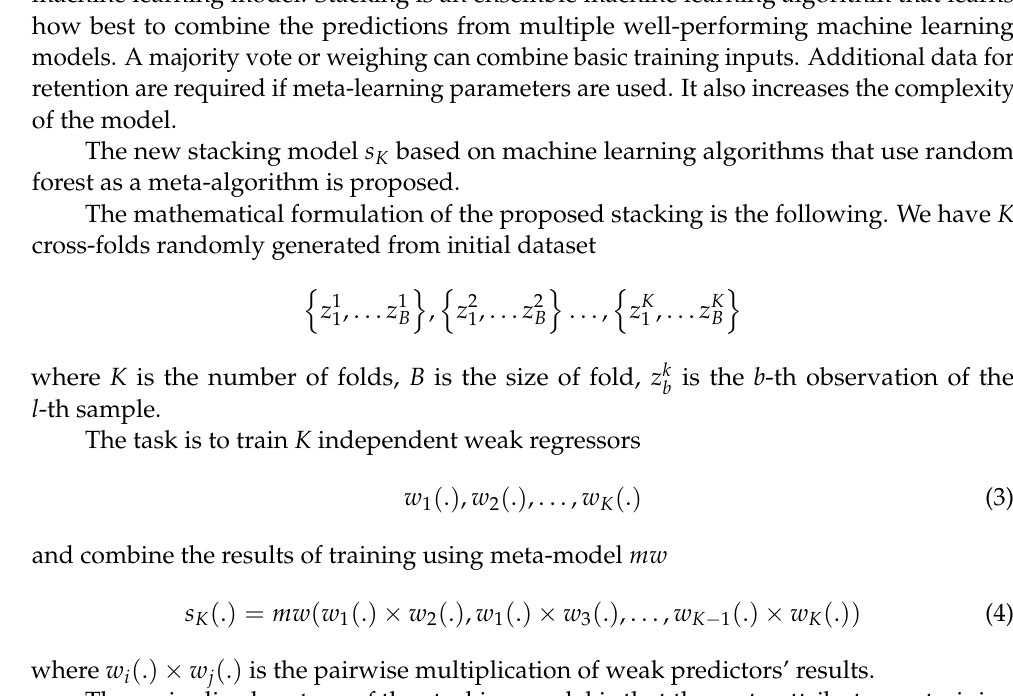
Figure 2. The predictive accuracy of bagging.